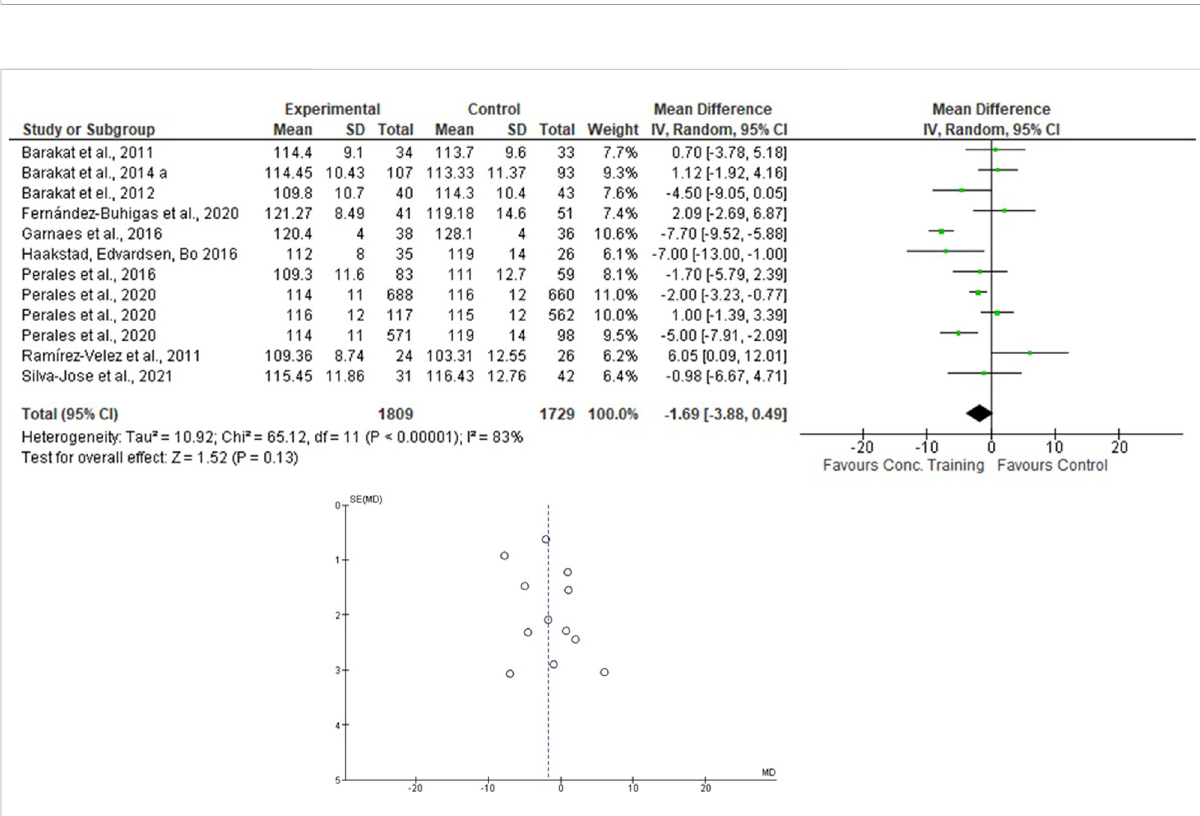
FIGURE 6 Effects of the AT + ST in pregnant women and funnel plot for detecting bias and heterogeneity.